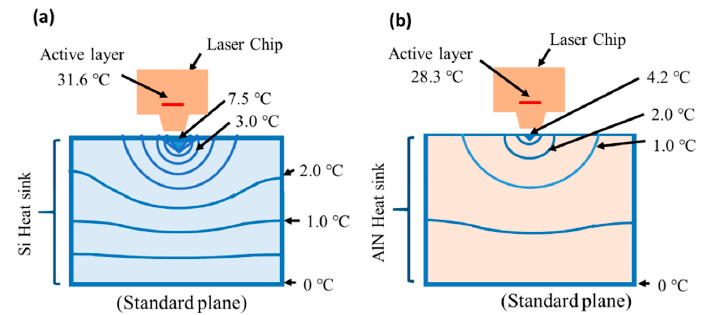
Figure A1. Simulated temperature of active layer: ( a ) Si heat sink; and ( b ) AlN heat sink.